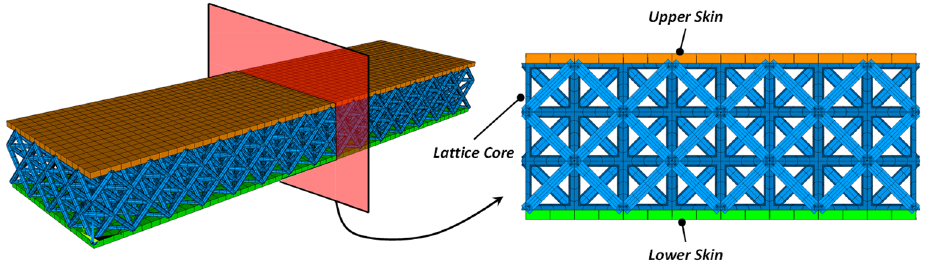
Figure 2. Investigated specimen with outer skins with the 3D-visualization of shell and beam sections.